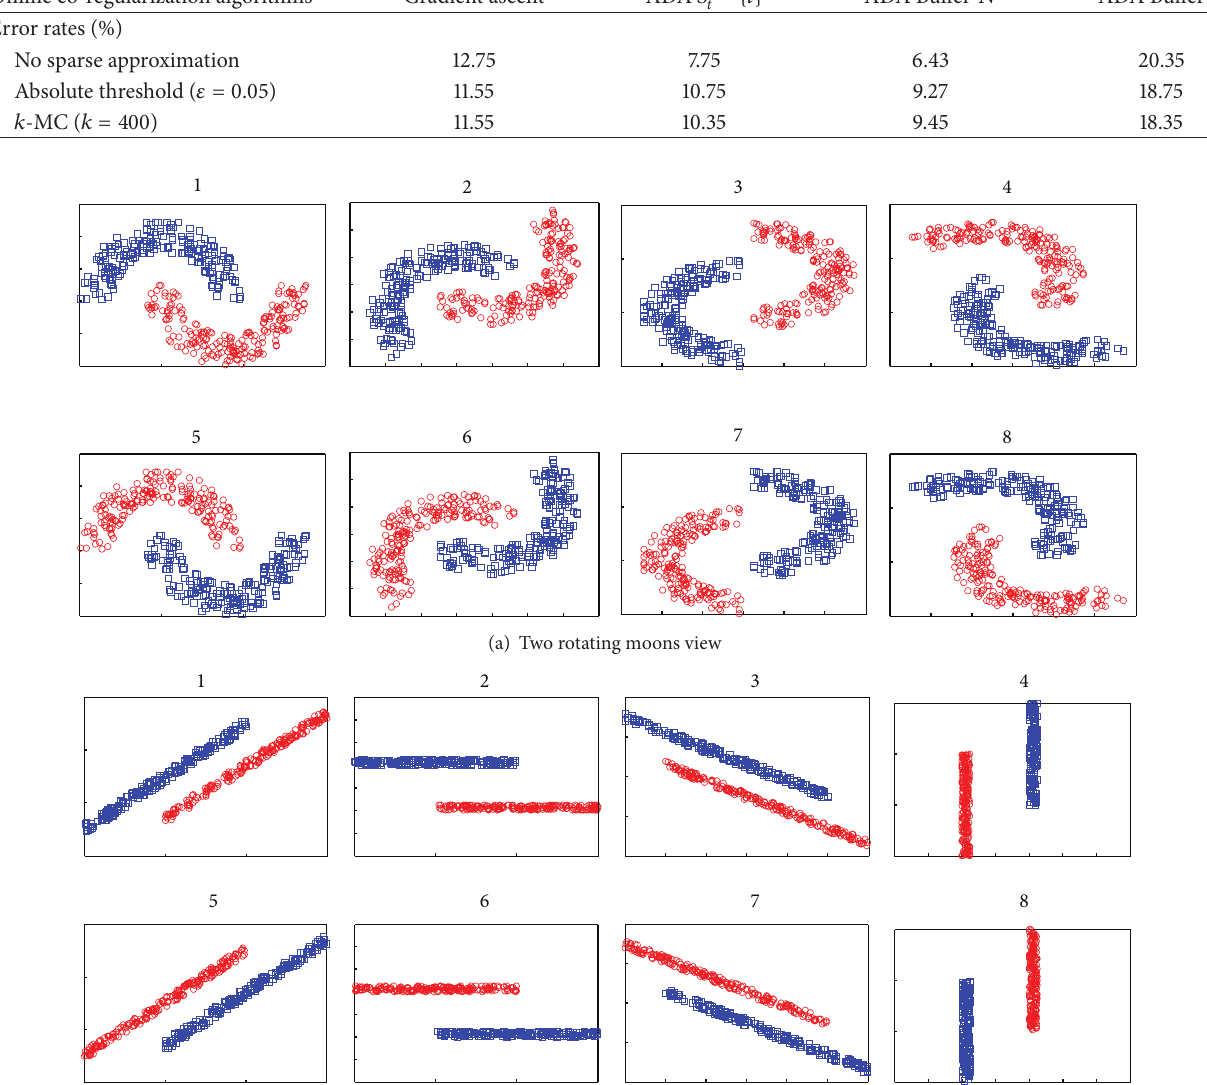
Table 4: Mean test error rates on the rotating two-moons-two-lines synthetic data sequence. The error rates are reported for three different sparseapproximations.Forgradientascent,wechooseastationarystepsize 𝜌 𝑡 = 0.1 .Theresultshowsthatourderivedonlineco-regularization algorithms are able to track the changes in the sequence and maintain a smaller error rate compared with batch learning algorithms. Specially, ADA (Buffer - 𝑁 ) performs better than the other online co-regularization algorithms.